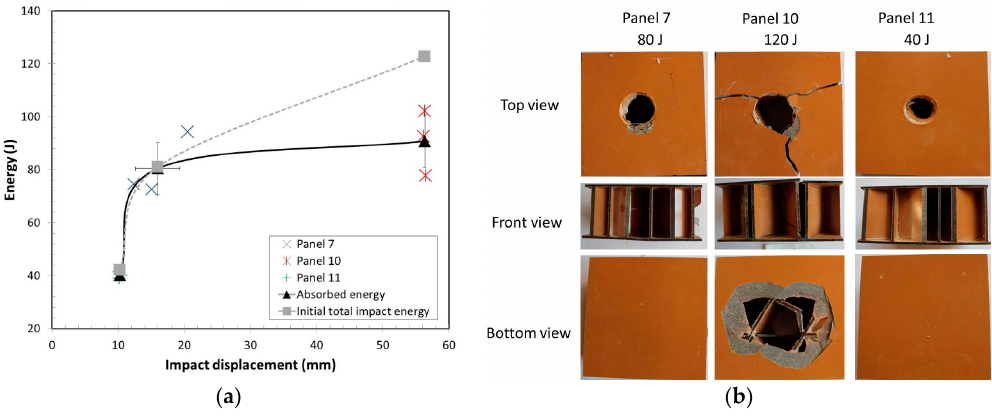
Figure 5. ( a ) Absorbed energy vs displacement at different initial impact energies; ( b ) Failure modes for panels at different initial impact energies.